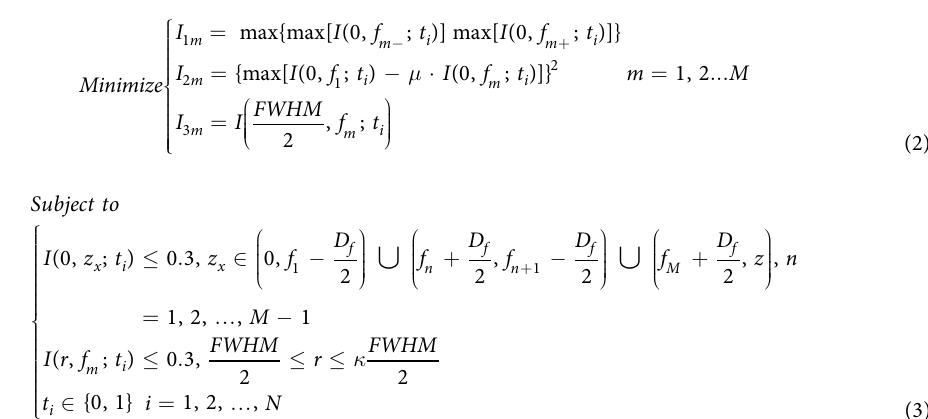
where the electric-field intensity I is normalized; M is the number of focal spots. f 1 , f 2 … f m represent the m-th location of the focal length; with D f being the depth of focus; t i is the transmittance value of the i -th annular ring and N is the total number of rings contained in the mask. For the binary amplitude-type annular mask, the contained concentric rings are initially set to be equidistant and each ring can have either unit or zero transmittance, so the binary amplitude transmittance is encoded straightforward using the two digits {0, 1}. We built the three-objective and three-constraint model to control the main properties of the 3D intensity distribution behind the SOLs. The first objective function Min .( I 1m ) means that the energy surrounding each focal spot along the optical axis should be less than the energy of each focus as much as possible, that is to ensure the intensity of the targeted focal spots are the peaks of the axial intensity distribution, which is useful for controlling the number of focal spots; the second objective function Min .( I 2m ) represents the ratio of focusing intensity; μ represents the difference of the intensity distribution between foci; μ = 1 means that the intensity distribution between the focal spots changes a little, thus each spot has the similar energy. It’s beneficial to achieve several homogeneous focal spots. The third objective function Min .( I 3m ) controls the sizes of the hotspots in the focal planes as small as possible, aiming to decrease the FWHM. On the other hand, the three constraints are used to control the light field parameters that we prescribe before optimizing, such as the intensity of the side lobe and FWHM. These objectives are related and difficult to control. Thus, we set a specific fluctuation range of the electric intensity distribution at different locations to ensure the light needed. As shown in Fig. 2, the intensity of the other points on the optical axis is set to below 0.3. A super-oscillation field always exists accompanied by high-energy side lobes, which will impede its widespread application 23 . Therefore, for the focusing planes perpendicular to the optical axis, the normalized intensity within the range of κ ≤ ≤ r FWHM FWHM , the radial width of the transition dark region between the central main lobe 2 2 and the surrounding side lobes is supposed to be lower than 30% of the peak intensity of the central lobe. A spe- cific fluctuation range of the side lobe was set to ensure the light field as required. If the parameter is unsuitable, it may be difficult to convergence to an optimal solution. After analyzing the energy relationship between the side lobe and the central spot, a side lobe factor of 0.3 is chosen in our design. GA is widely used for such problems due to its powerful parallel and global searching capability 24, 25 . Since a sub-diffraction-limit multifocal field is influenced by many factors, and these factors often conflict with each other. When we reduce the spot sizes, there always comes along with the increase of intensity for sidebands. Therefore, there exists a tradeoff of the light energy between the central foci and their side lobes. A feasible tradeoff is achieved when there are no significant side lobes, and meanwhile, the spot sizes maintain a good uniformity beyond the diffraction limit. The multi-objective optimization problem makes the components